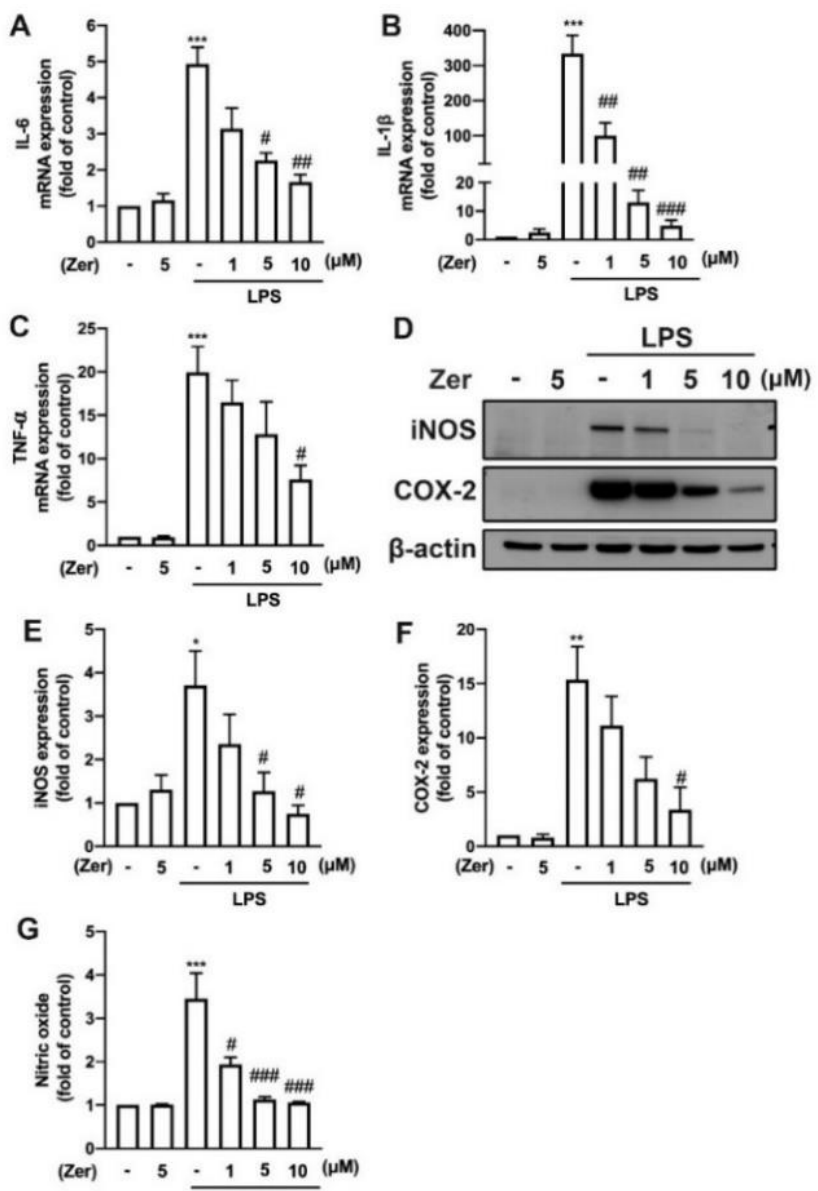
Figure 5. The expression of proinflammatory mediators in response to zerumbone in macrophages. RAW264.7 cells were supplemented with different concentrations of zerumbone (1, 5, or 10 μM) for 30 min and then stimulated with LPS (50 ng/mL) for another 6 h ( A – C ) or 24 h ( D – G ). Expressions of IL-6 ( A ), IL- 1β ( B ), and TNF- α ( C ) mRNA were analyzed using real-time PCR and normalized to β -actin. ( D ) iNOS and COX-2 protein expressions were analyzed using Western blotting. Quantitative results are shown in ( E ) and ( F ). ( G ) The cultural supernatant was harvested for measuring NO production by NO assay. Each bar represents the mean ± SEM ( n = 3 or 4). * p < 0.05, ** p < 0.01, *** p < 0.005 compared with the control group. # p < 0.05, ## p < 0.01, ### p < 0.005 compared with the LPS alone group.